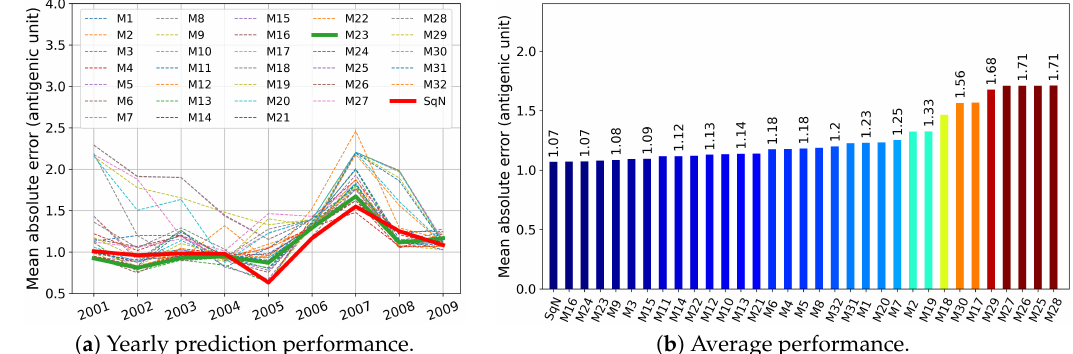
Figure 12. Experiment T 3 : the models were trained on a three-year